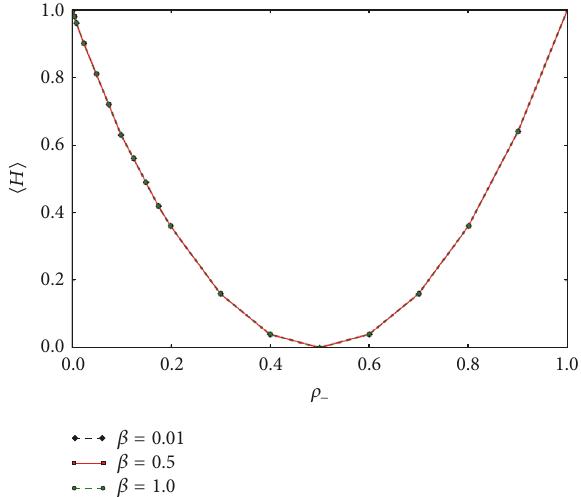
Figure 6: Hamiltonian of a fully connected community, in function of the density of negative spins. Results have been averaged over different simulation